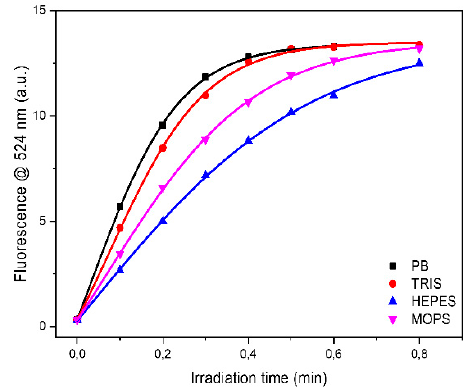
Figure 4. Time-courses of DHR-123 conversion in the presence of HEWL in different buffers. Solutions were irradiated using UV-C lamps in a BioLink 254 photoreactor. Fluorescence spectra were recorded after excitation at 505 nm with a bandwidth of 4 nm.